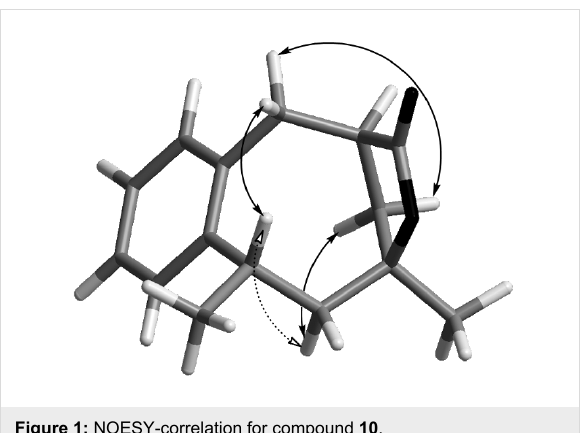
Figure 1: NOESY-correlation for compound 10